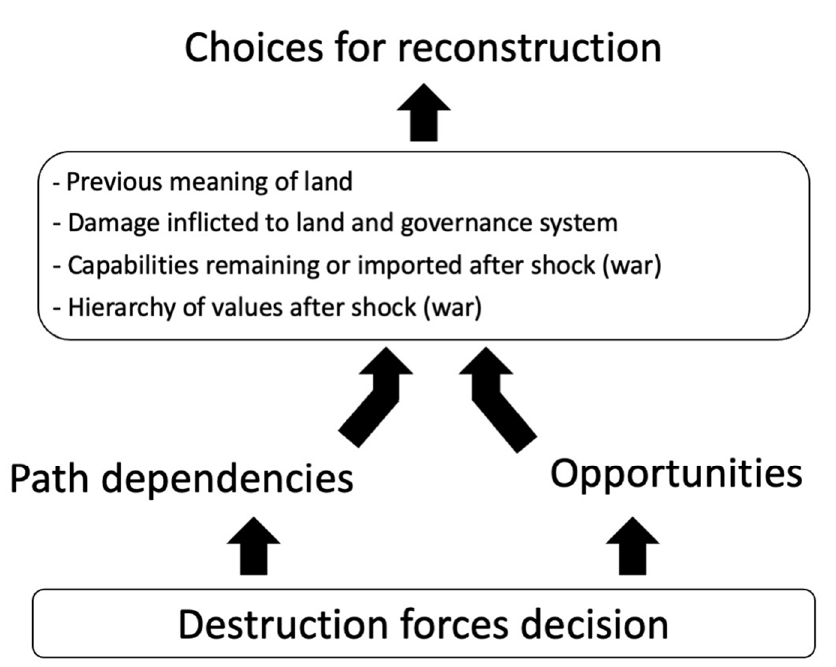
Figure 5. Decisions and choices after war. The choices for reconstruction are highly path dependent and they introduce new path dependencies, at the same time, damage done by the war can open new possibilities. The war can function as a reset by weakening interdependencies and introduce opportunities by opening space for new actors and institutions, replacing less persuasive narratives and replacing fragmented infrastructure in the system.